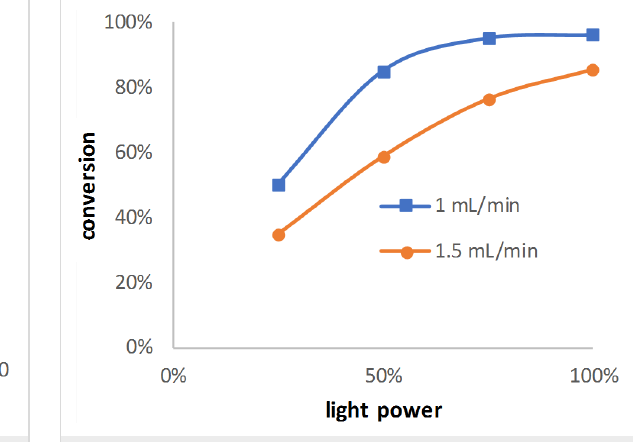
Figure 9: Conversion of alpha-terpinene (0.5 N) as a function of the wavelength using DMA ( Gb ) as the catalyst (7.25 mmol/L).